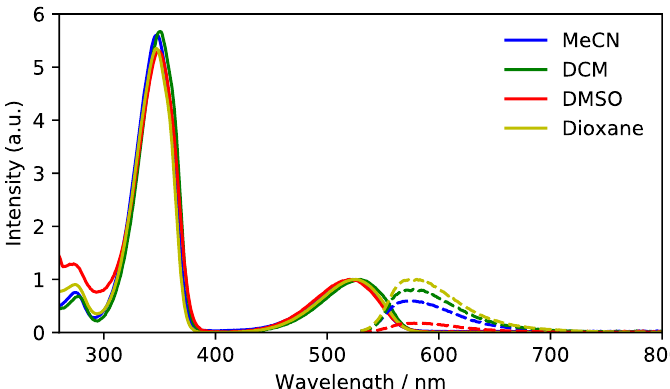
Figure 1. Absorption and emission spectra of C 16 C 16 in four different solvents. The absorption spectra were normalized relative to the n π ∗ absorption. The emission intensities were normalized relative to the maximum emission in dioxane, corrected for the differences in absorption of the samples, and multiplied by the solvent refractive index squared so that the maximum intensities reflect relative φ f .